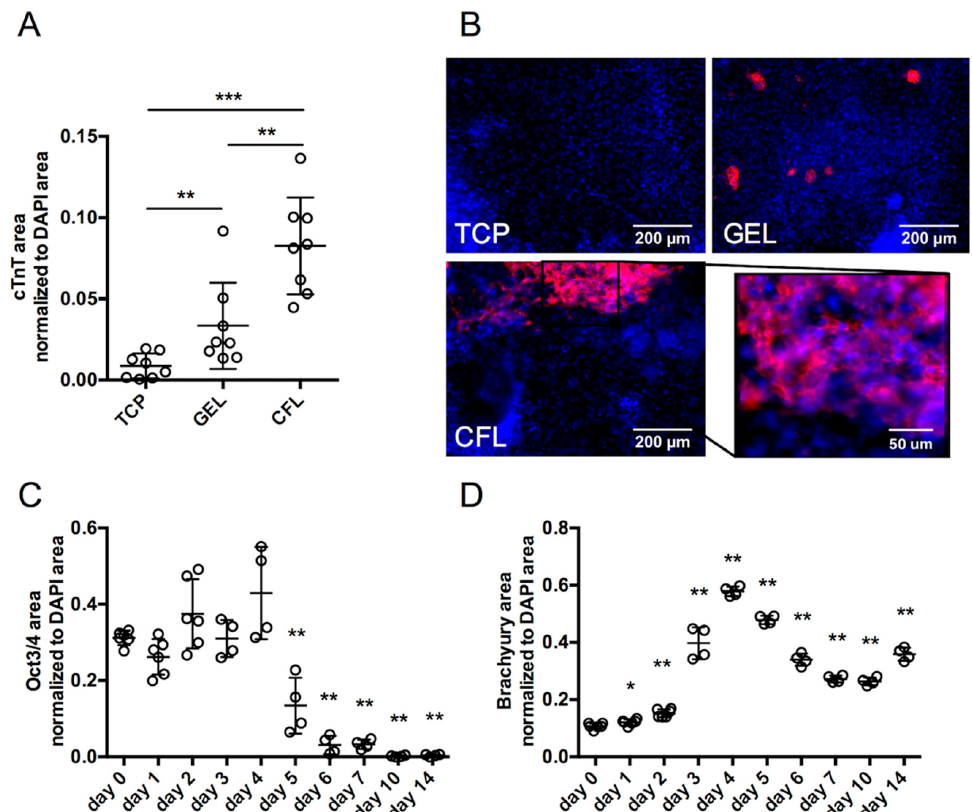
Figure 1. Differentiation of miPSCs into cardiomyocytes upon ECM engagement. ( A , B ) Immunofluorescence staining of cTnT at 14 days of culture with tissue culture plastic (TCP), gelatin 0.1 % (GEL), or ECM mixture comprised of collagen type I, fibronectin, and laminin-111 (CFL) and its associated quantification of cTnT staining normalized to DAPI area. ( C ) Quantification of pluripotency marker Oct3/4 immunofluescence staining at different time points of differentiation of miPSCs upon CFL culture condition. ( D ) Quantification of mesodermal marker Brachyury/T immunofluorescence staining at different time points of differentiation of miPSCs upon CFL culture condition. Comparison of mean between TCP, GEL, and CFL or day 0 condition to the other days. * p < 0.05, ** p < 0.01, *** p < 0.001, unpaired t -test with Mann–Whitney U test.